Question: What form of chart is displayed?
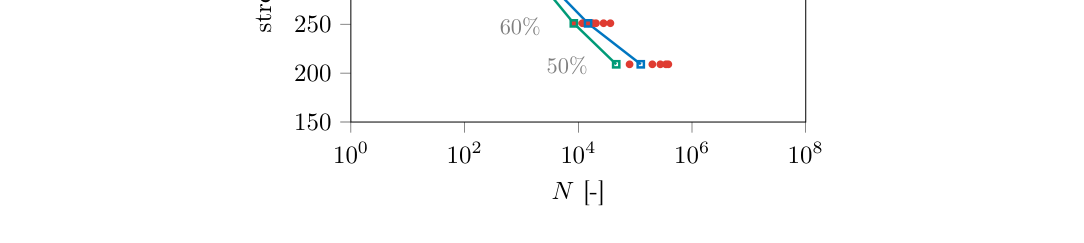
Answer: line